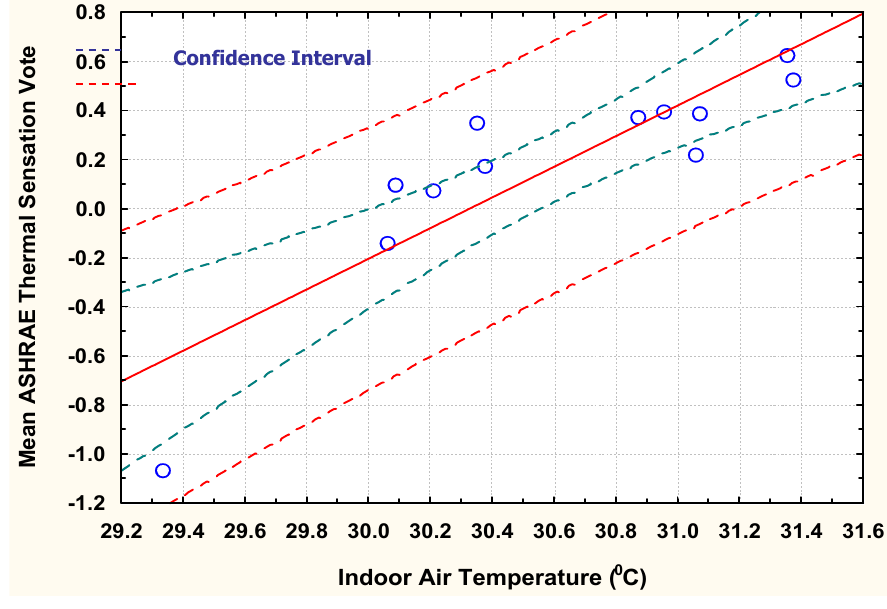
Figure 5. Mean hourly air temperature (°C) vs. mean votes on the ASHRAE